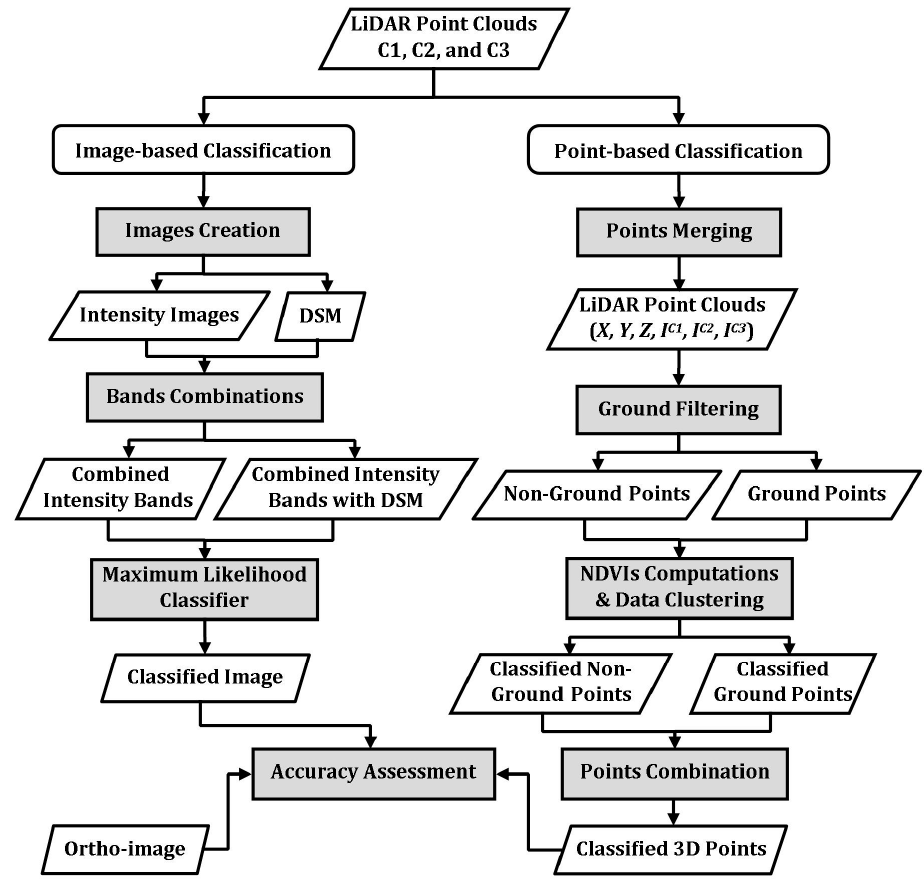
Figure 1. Classification workflow.